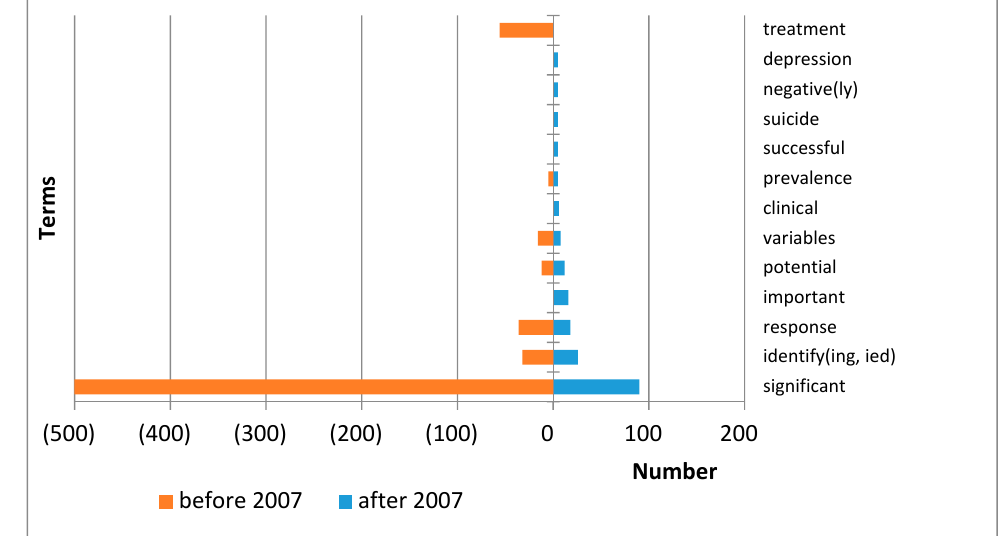
Figure 5. The frequency of occurrence of terms in the vicinity of the derivative “predictor(s)” over the past decade.